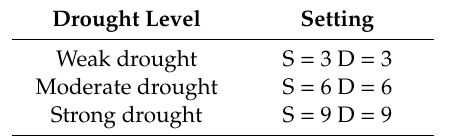
Table 2. Drought level parameters according to the criteria of Wang et.al, [33].